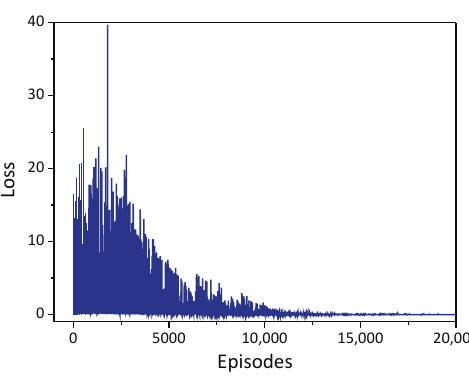
Figure 4. The reward curve of F-DQN.